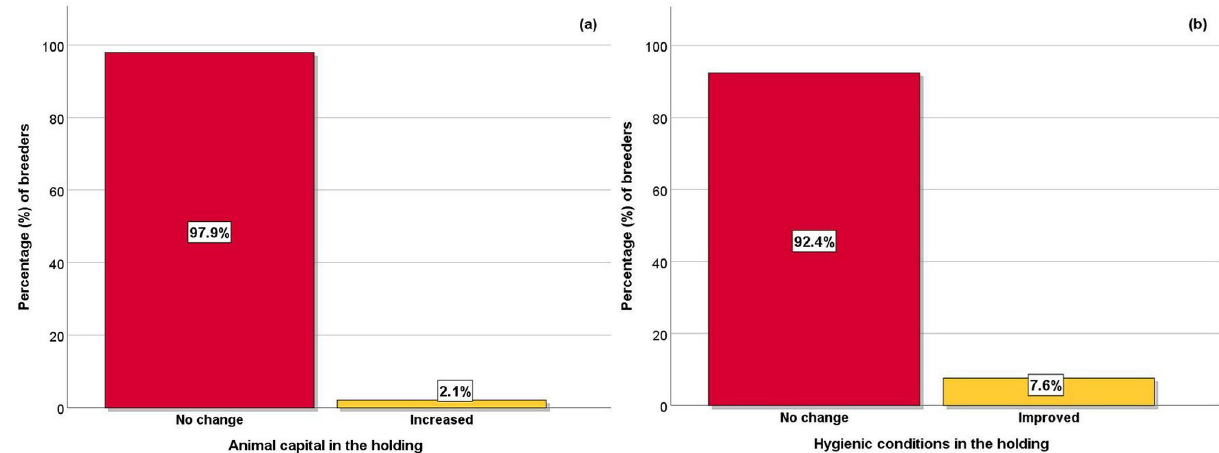
Figure 3. Effect of COVID-19 restrictive measures on (a) animal capital and (b) the hygienic conditions in the holdings.